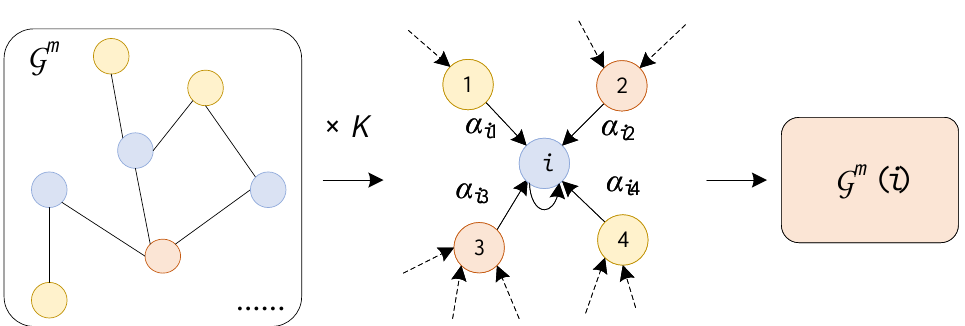
Figure 3. Subview information extraction.